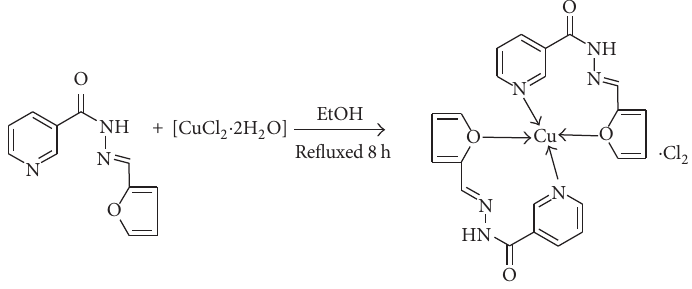
S 4: Route for the synthesis of the copper